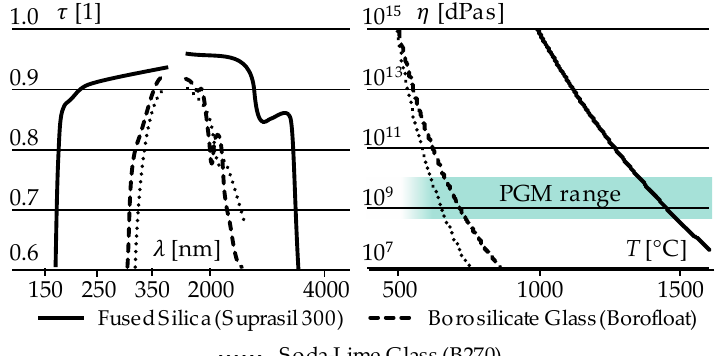
Figure 2. Approach used for studying the wear behaviour of Glassy Carbon forming tools in Fused Silica PGM.